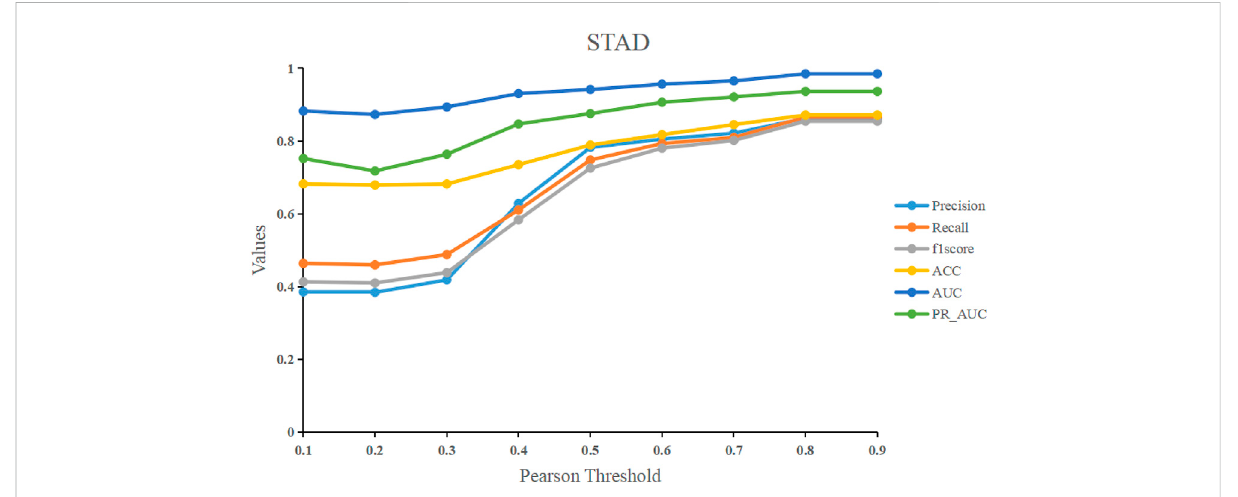
FIGURE 7 The effect of different Pearson correlation thresholds on model performance.